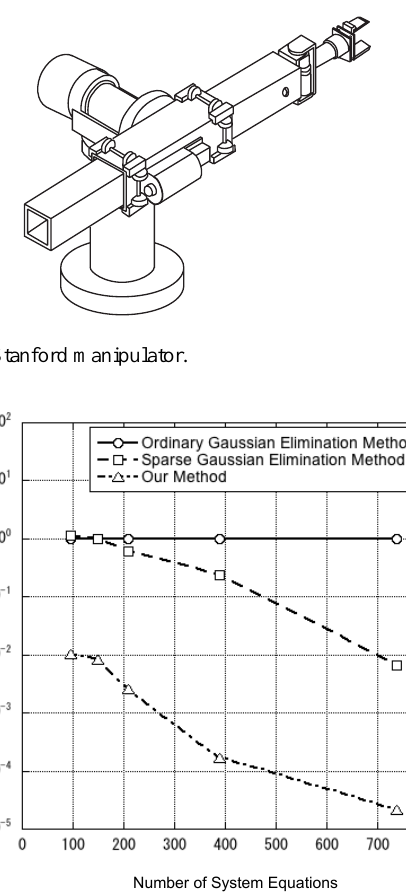
Figure 10. Comparison of CPU time.